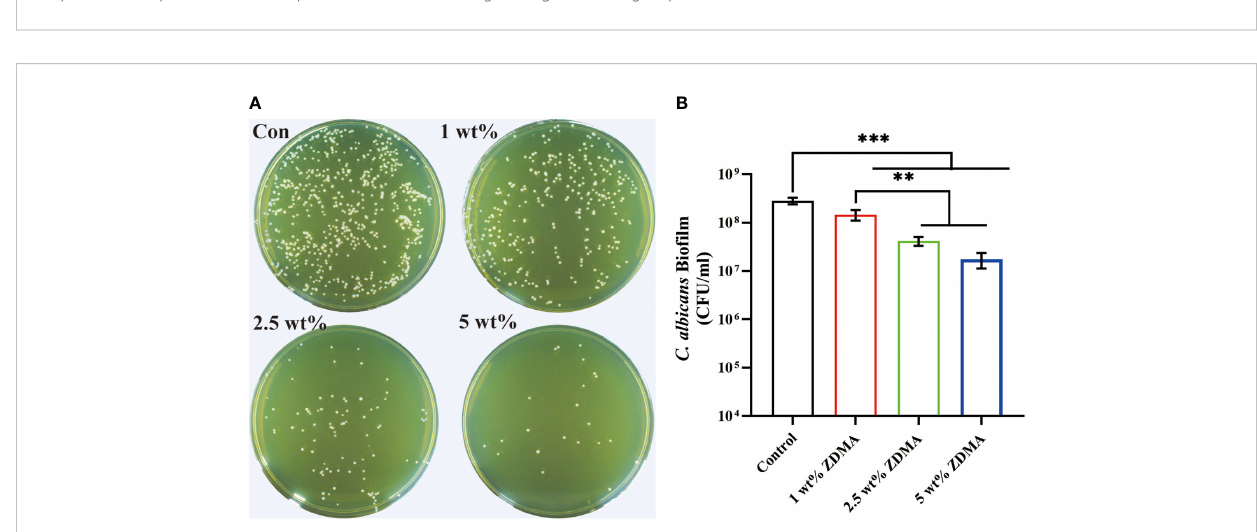
FIGURE 6 The number of C. albicans colonies detached from each group. (A) Representative images of C. albicans colonies of each group. (B) Means ± standard deviations for C. albicans colonies of each group ( **p < 0.01, ***p < 0.001).